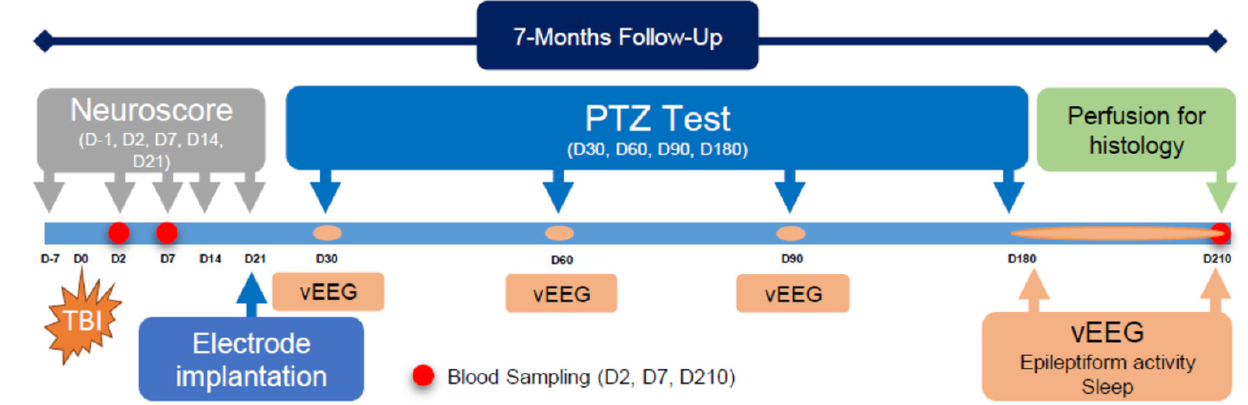
Figure 1. Study design: Epileptogenesis was triggered by lateral-fluid-percussion-induced traumatic brain injury (TBI, injury day (D) 0). The composite neuroscore test was performed at baseline (before TBI), and then on D2, D7, D14, and D21 post-TBI. Tail vein blood was sampled on D2 (48 h), D7, and D210 after TBI (data not shown). Epidural cortical electrodes were implanted on D21. Sei- zure susceptibility was assessed with the pentylenetetrazol (PTZ, 25 mg/kg, intraperitoneally) test on D30, D60, D90, and D180. Video electroencephalography (vEEG) was monitored starting 24 h before, during, and for 24 h after each PTZ test. During the 7th post-injury month (D180–D210), animals were continuously monitored via vEEG to detect spontaneous seizures and record sleep.